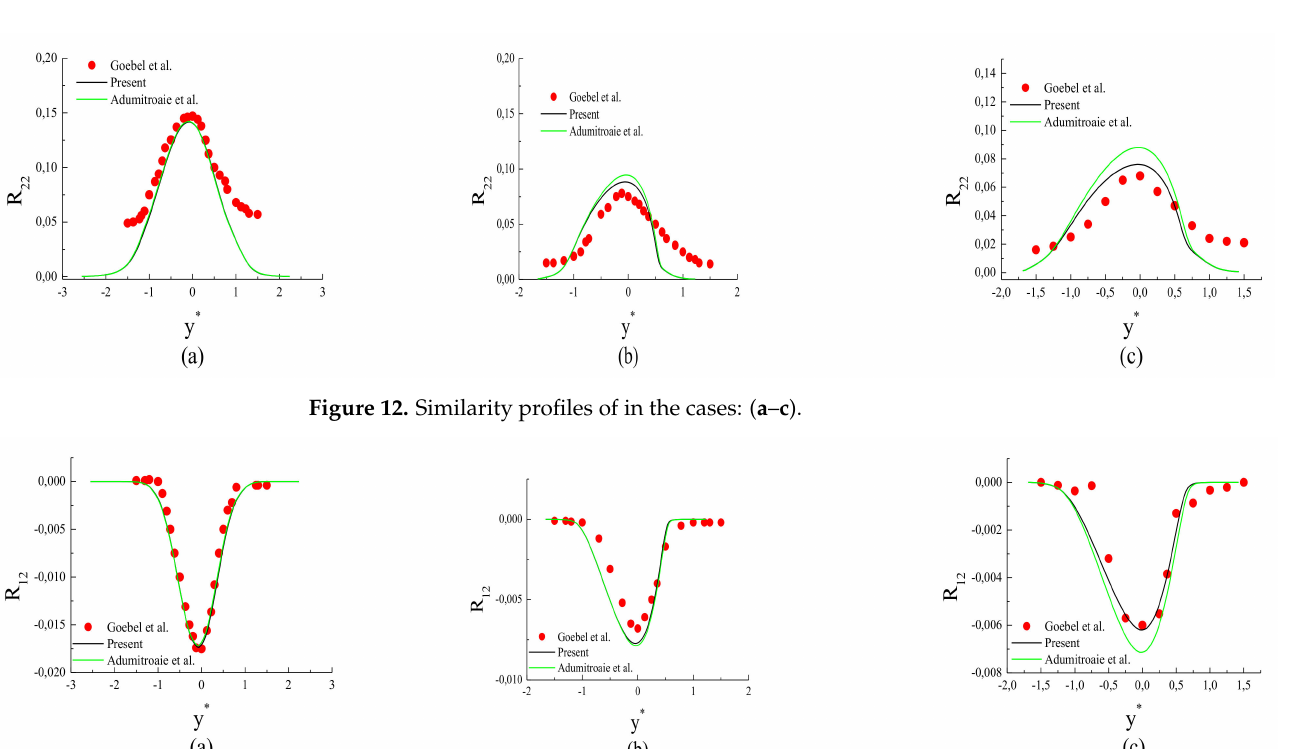
Figure 13. Similarity profiles of R 12 in the cases: ( a ) M c = 0.2, ( b ) M c = 0.69, and ( c ) M c = 0.86.